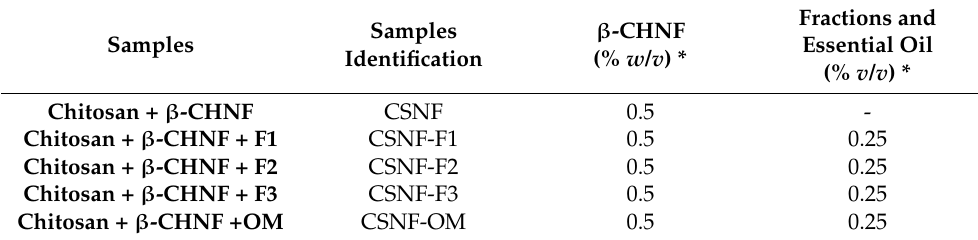
Table 1. Identification and composition of the nanocomposite